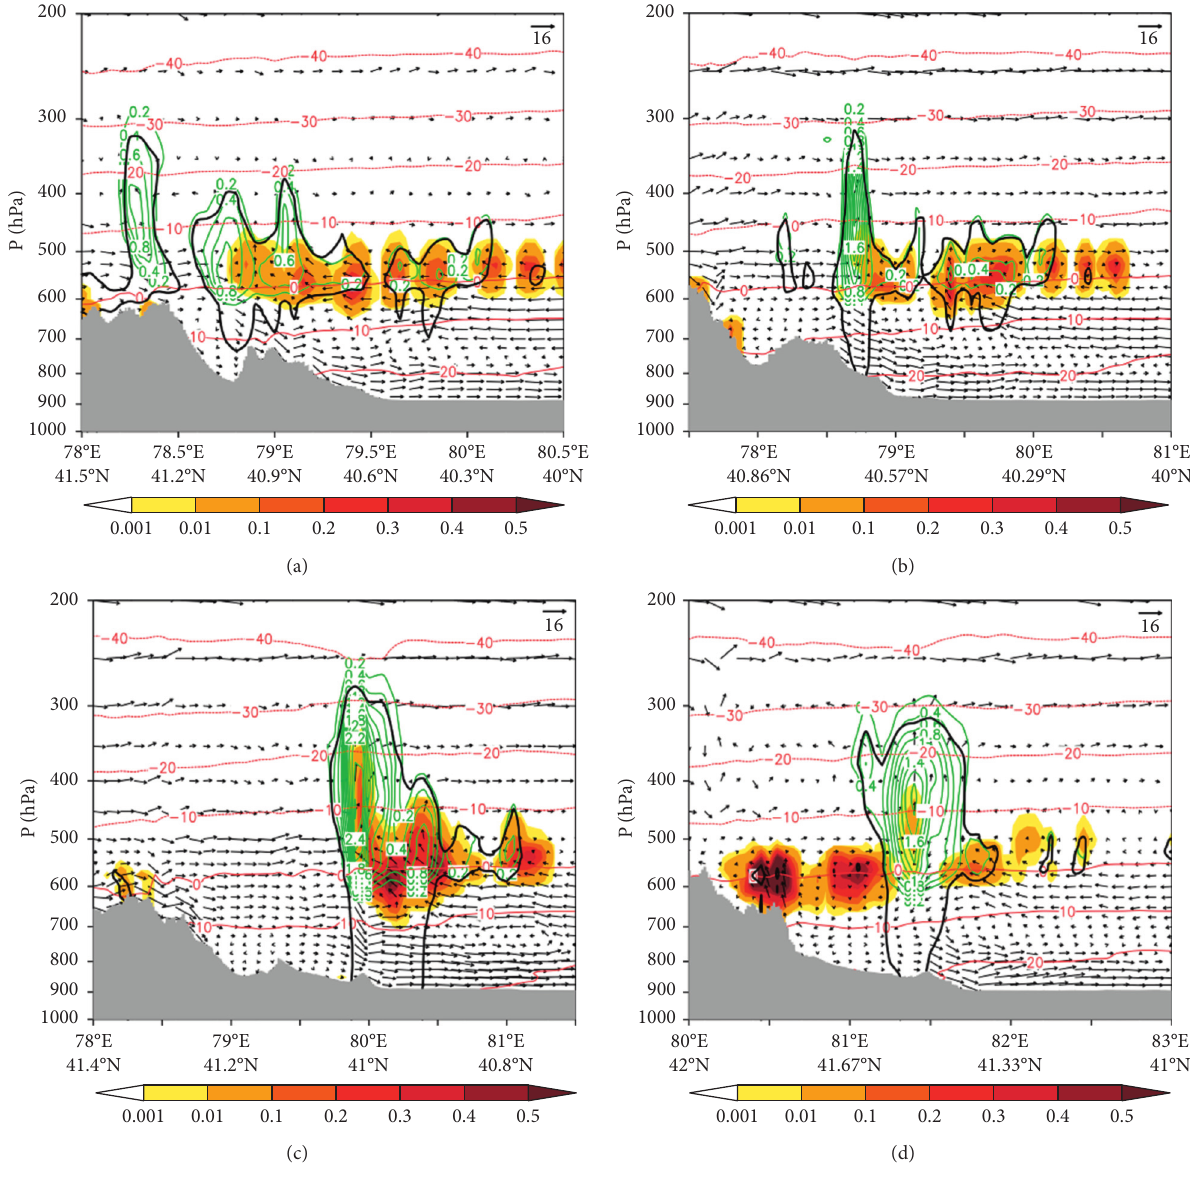
Figure 10: Vertical cross sections of the simulated concentration of ice-phase particles (shaded, unit: g · kg − 1 , including ice, snow, and graupel), the concentration of cloud water (green solid line; unit: g · kg − 1 ), and temperature (red solid line, unit: ° C) along the black solid line CD shown in Figure 5. (a) Initiation stage at 12:00 on July 31. (b) Development stage at 16:00 on July 31. (c) Maturity stage at 17:30 on July 31. (d) Extinction stage at 22:00 on July 31,